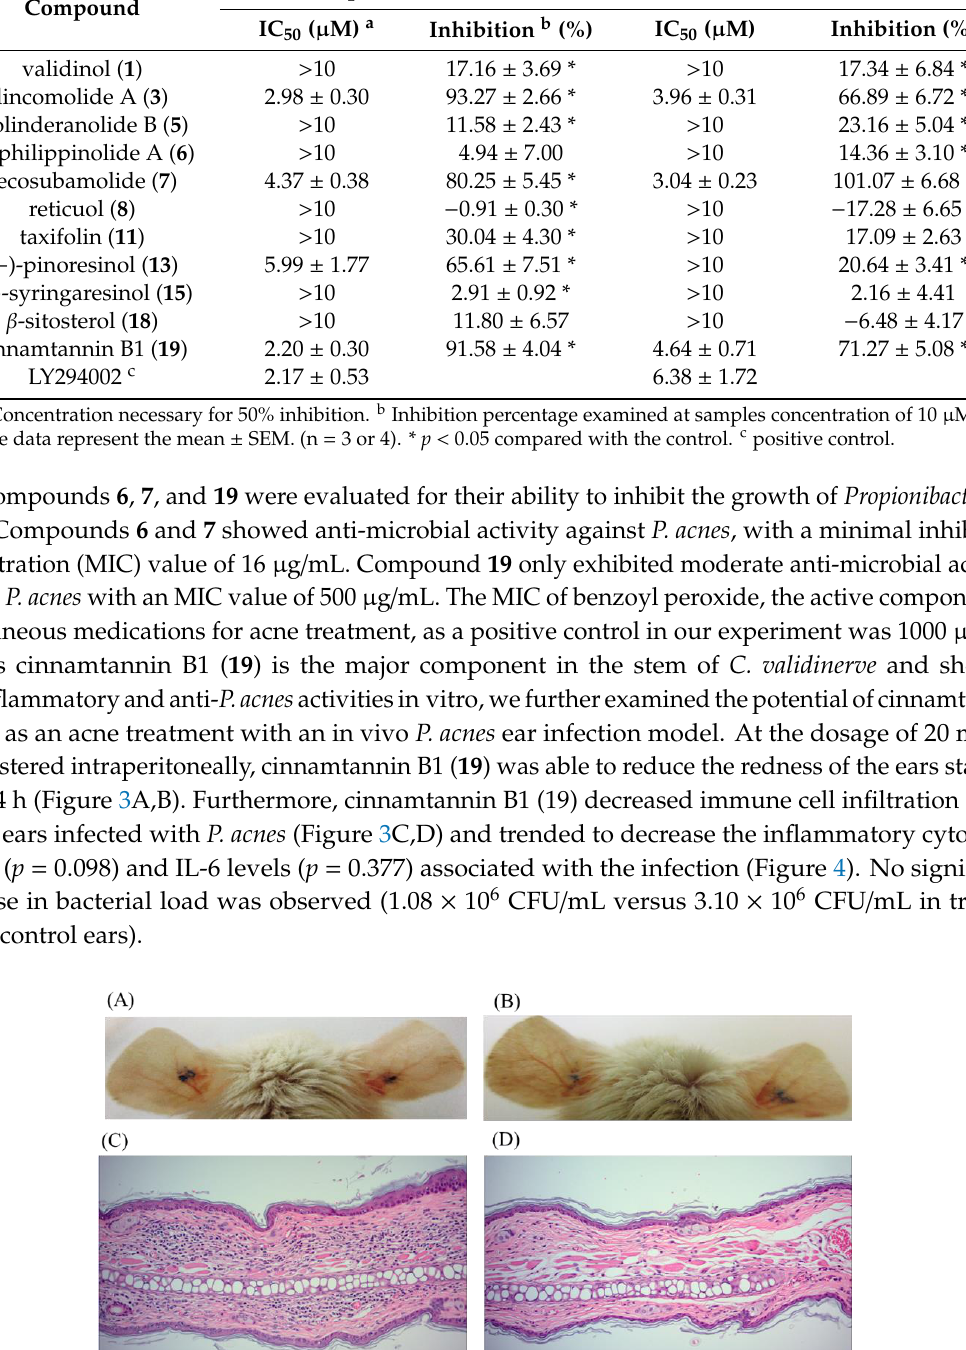
Table 1. Effect of compounds on superoxide anion generation and elastase release in N -formyl peptides formyl-l-methionyl-l-leucyl-l-phenylalanine (fMLP)/CB-stimulated human neutrophils.